Question: Author a descriptive caption for the visualization shown.
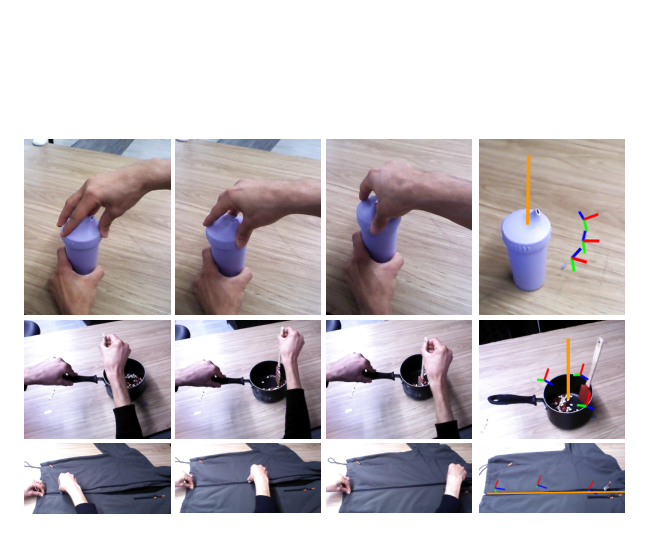
Answer: Human demonstrations as screw actions. Three frames of a human demonstration for three bimanual tasks (top row: opening a bottle, m = revolute, middle row: stirring a pot, m = revolute3D, bottom row: opening a zipper, m = prismatic) and the perceived screw axis explaining the motion (fourth column, orange indicates the axis line). Our screw action representation facilitates the interpretation of noisy hand trajec- tory observations in a bimanual interaction as evidence of a simple 1-DoF constraint between both hands